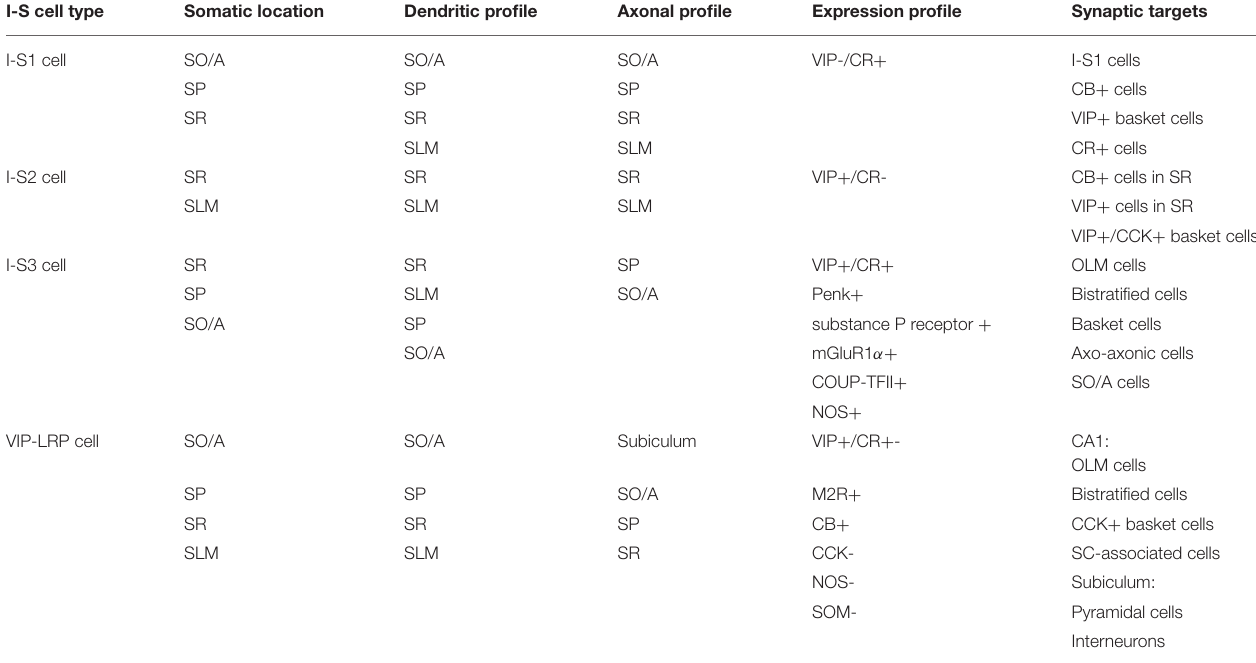
TABLE 1 | Hippocampal CA1 I-S cell